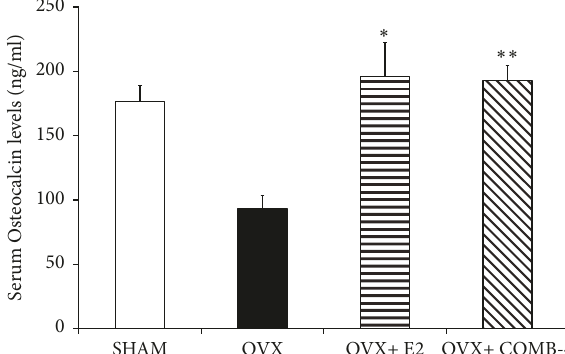
Figure 4: Level of Serum Osteocalcin after 100 days treatment with E2 or COMB-4 following OVX. Osteocalcin (ng/ml + SEM) in serum was determined by ELISA in SHAM, OVX, OVX+E2, and OVX+ COMB-4 groups. ∗ p < 0.05; ∗∗ p < 0.01 with respect to OVX. n = 8 per